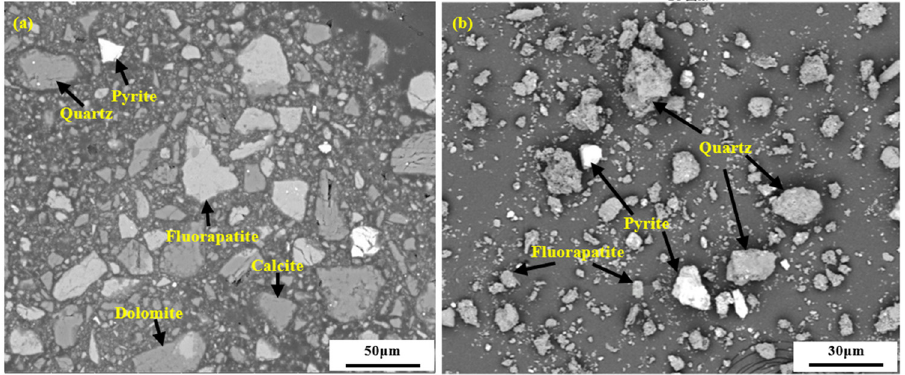
Figure 9: SEM images of phosphate ore before ( a ) and after ( b ) leaching for 120